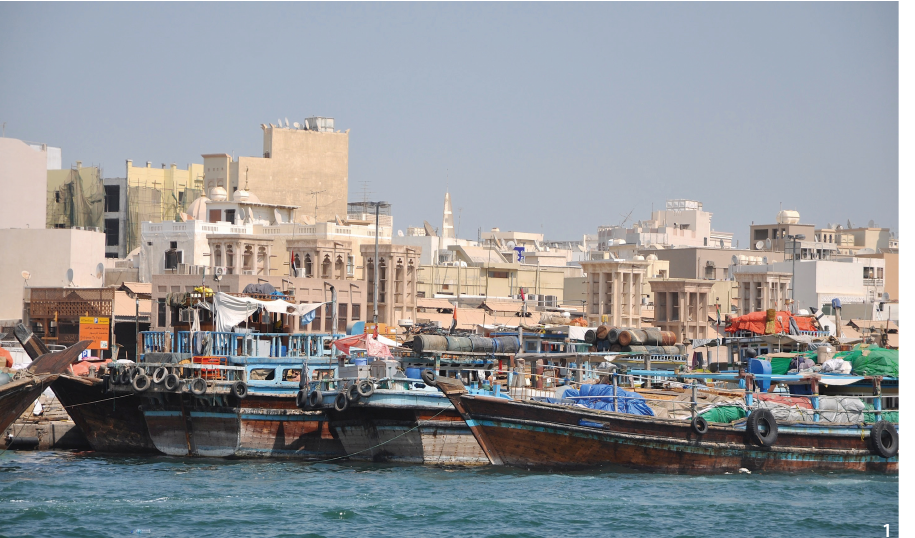
Figure 1 Wooden dhows in Dubai Creek, 2013 (Source: F. Cristofoli).